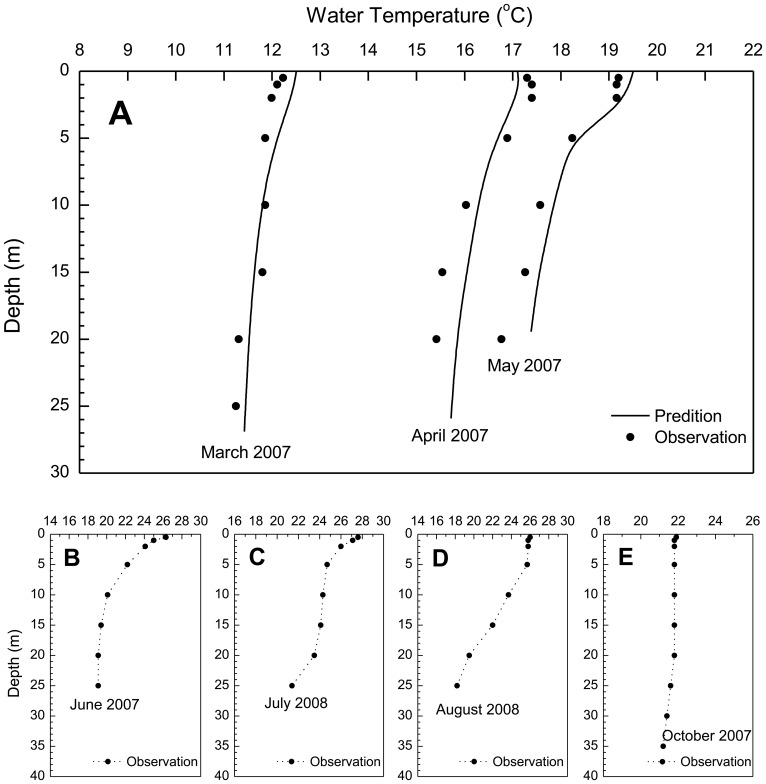
Temperature profiles at Station Xiakou: (a) comparisons between simulation and measurement in March, April, and May 2007; (b) observed values in June 2007; (c) and (d) observed values in July and August 2008 (after Ref [34]
); (e) observed values in October 2007.